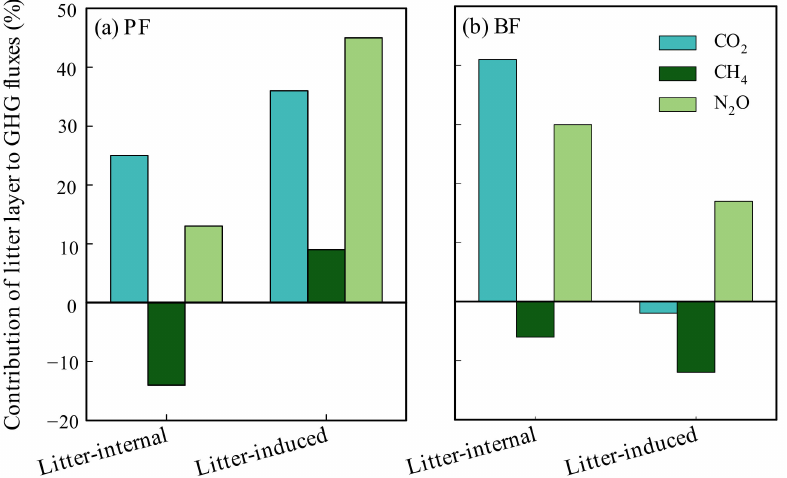
Figure 2. Contributions (%) of litter-internal (f L-L ) and litter-induced (f L-S ) to CO 2 , CH 4 , and N 2 O fluxes ( F CO2 , F CH4 , and F N2O ) in PF (Masson pine forest) and BF (evergreen broadleaved